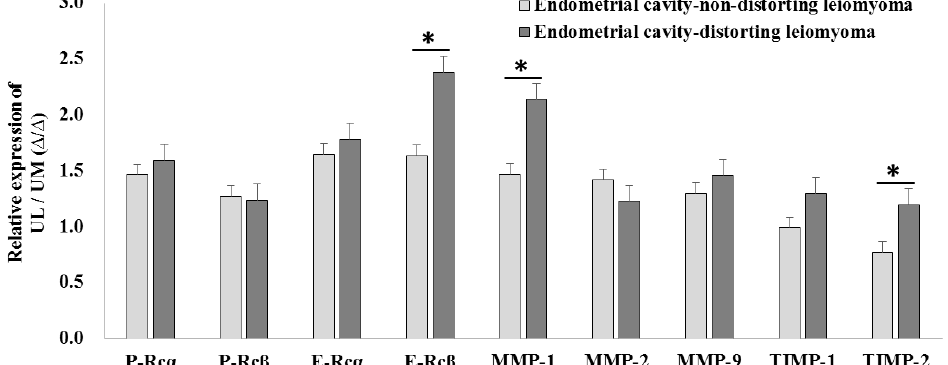
Figure 7. The comparison of relative candidate target gene expression in endometrial cavity-distorting and endometrial cavity-non-distorting leiomyoma cells compared to uterine myometrial cells (* p > 0.05).